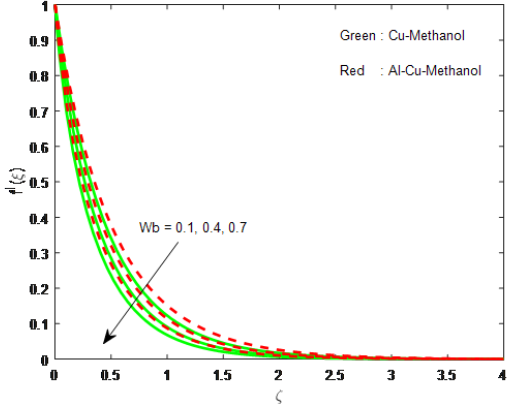
Fig. 7: Impression of H 2 on θ ( ξ ) Fig. 8: Impression of wb on f (cid:48) ( ξ